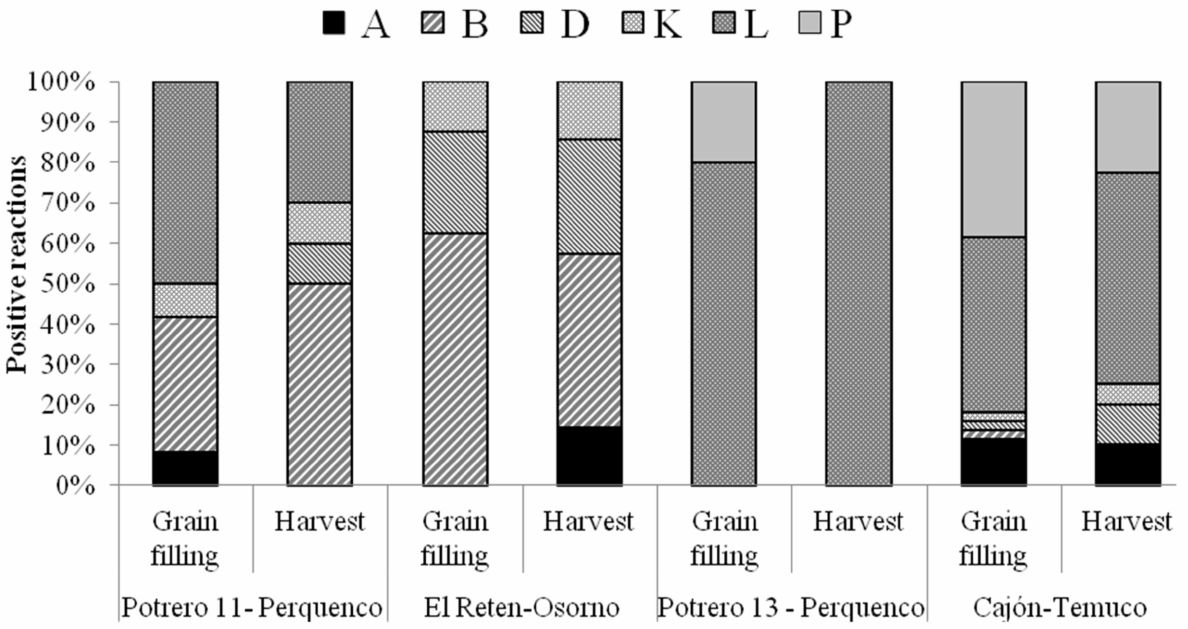
Figure 3. Frequency of genotypes of phlD + identified in bacterial populations isolated from the rhizosphere of wheat plants obtained from sampling points sampled by amplification with specific primers, according to the protocol by De la Fuente et al. [18] in four intensively sampled fields of southern Chile during the grain-filling and harvesting